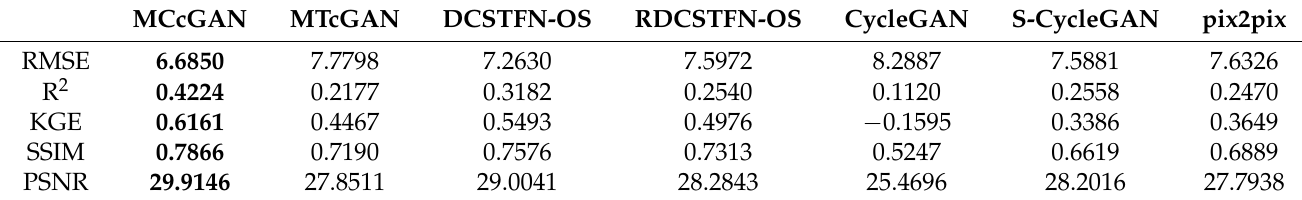
Table A6. The evaluation metrics of different methods for the blue band in Area B at Time IV (the bold result is the best among the different metrics).